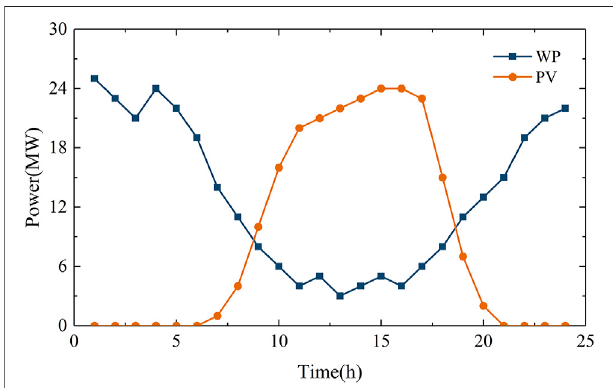
FIGURE 3 | Forecast curve of wind power and photovoltaic power generation.